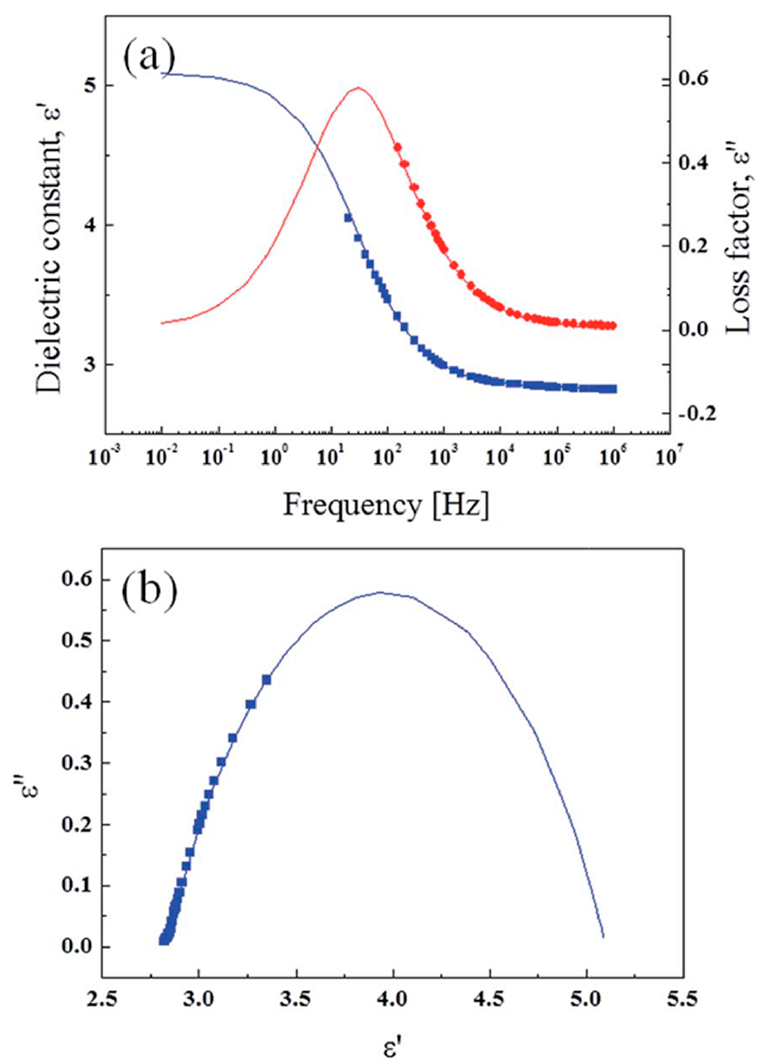
Figure 15. Dielectric properties for PS/PANI-based ER fluid: ( a ) Dielectric constant (blue square) and loss factor (red circle) as a function of the frequency; ( b ) Loss factor as a function of the dielectric constant. The solid lines are drawn using Equation (10). (Kim et al. [128], Copyright The Royal Society of Chemistry, 2015).